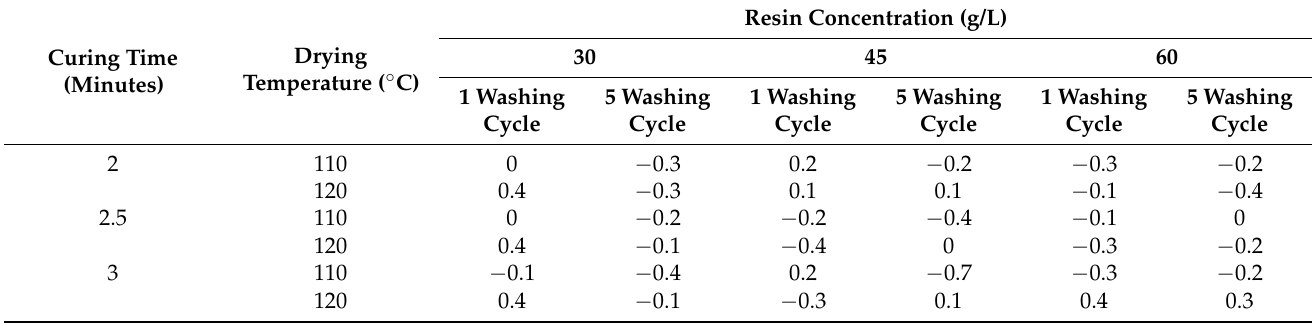
Table 10. Relationship between resin concentration and dimensional change in